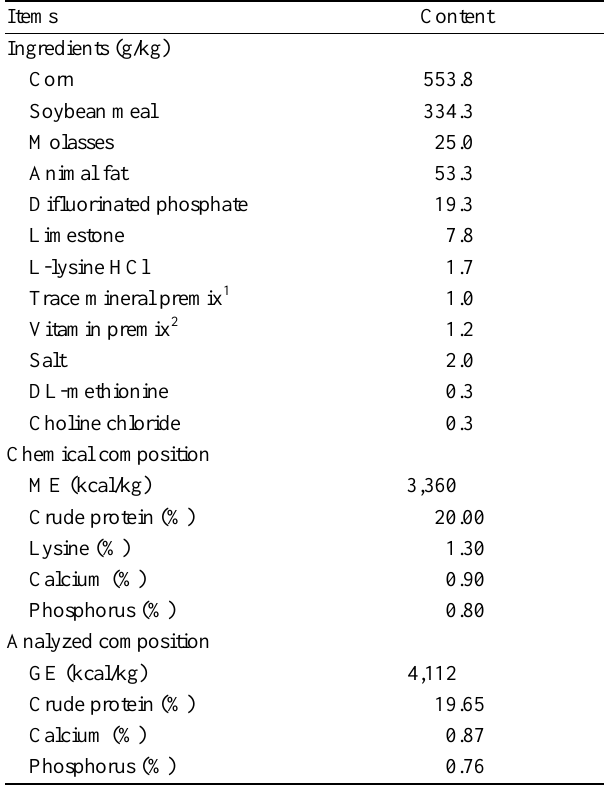
Table 1. Composition of the basal experimental diets (as-fed basis)